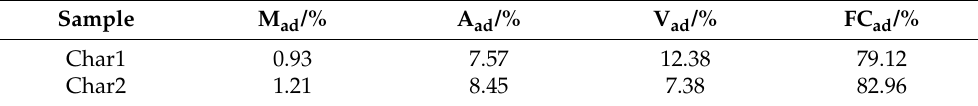
Table 1. Proximate analysis of char1 and